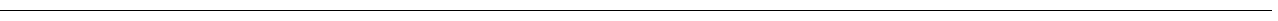
Fig. 2 On- and off-target hypermethylation of tumour suppressor genes in primary cells. a – d EPIC array at targeted promoter regions of a HIC1 , b PTEN , c RASSF1 and d CDKN2A . gRNA (grey arrows point towards PAM sequence) in relation to CGI (in green) and TSS of genes, percentage methylation from dCas9 3A3L Δ targeted cells (pink line) compared to 3A3L targeted cells (black line), 10 days post-transfection of primary myoepithelial cells from donor 1 and after magnetic sorting on day 2 (mean ± SEM; n = 3; excluding error bar if smaller than plotted point). e Scatter plot of EPIC data comparing